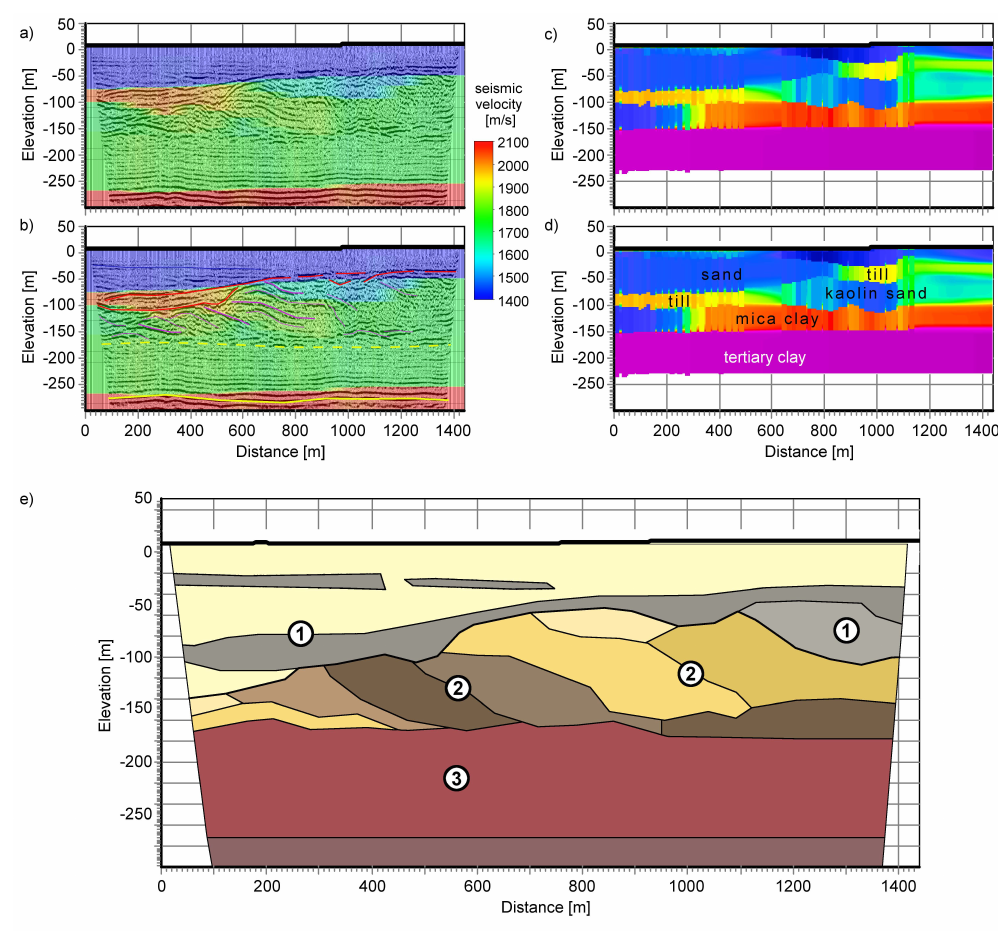
Fig. 8. Structural interpretation of geophysical data: (a) seismic reflection depth section with interval velocities; (b) and marked horizons; (c) SkyTEM resistivity cross-section (for colorscale see Fig. 4d); (d) with interpretation; and (e) interpretated block cross-section with (1) buried valleys (grey: till; bright yellow: sand), (2) glaciotectonic structures below, and (3) undisturbed Tertiary